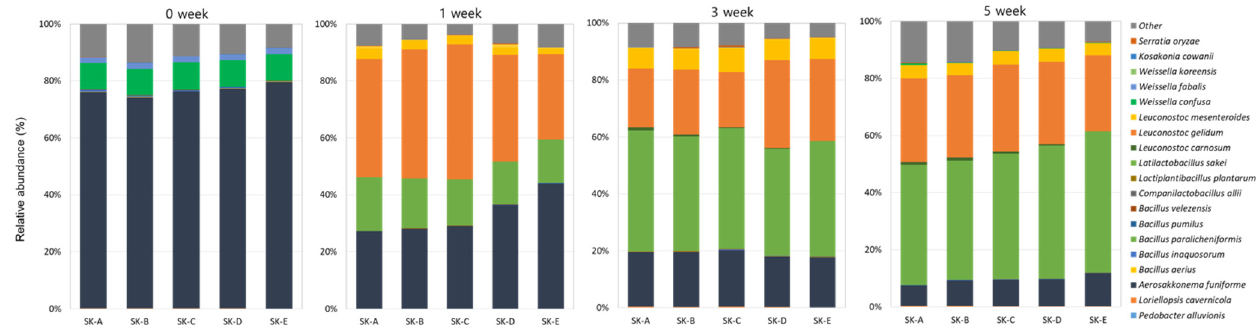
Figure 1. Bacterial community composition at the species level in kimchi fermented at different salinities, as found using the SILVA rRNA database. ‘Other’ is composed of genera among which each shows a percentage of reads <0.5% of the total reads in all kimchi samples in species-level analyses.